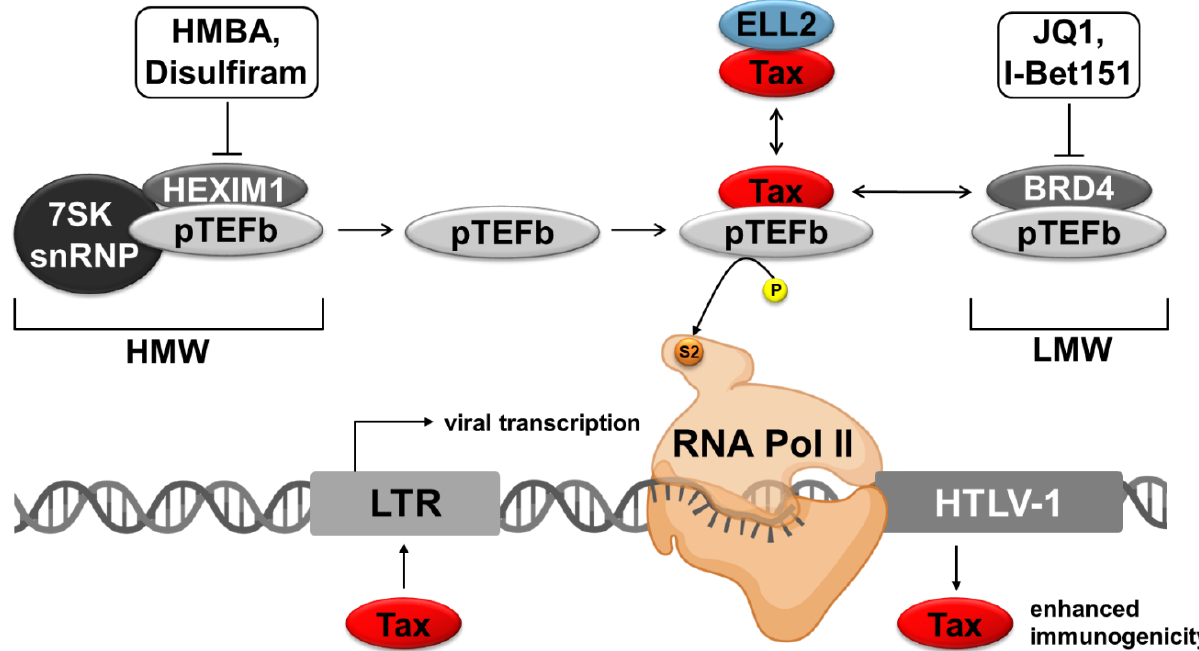
Figure 3. Activators of pTEFb as latency-reversing agents for HTLV-1. The cellular function of the positive transcription elongation factor b (P-TEFb) is to release the RNA Pol II from promoter proximal pausing by phosphorylating Ser2 in the carboxyterminal domain. The level of activity of P-TEFb is governed by its existence in complexes with different cellular proteins. In the inactive high molecular weight complex (HMW), P-TEFb interacts with HEXIM1 and 7SK snRNP; in the low molecular weight complex (LMW), P-TEFb complexes with BRD4, thus, activating transcription. Targeting these complexes to achieve the release of P-TEFb facilitates the binding of P-TEFb to the viral transactivator Tax. The complex of pTEFb and Tax could activate HTLV-1 transcription most effectively, resulting in enhanced Tax protein expression. Additionally, complexes between the P-TEFb-related transcription elongation factor ELL2 and Tax exist. Abbreviations: P-TEFb, positive transcription elongation factor b; 7SK snRNP, 7SK small nuclear ribonucleoprotein; HEXIM1, hexamethylene bisacetamide inducible protein 1; HMBA, hexamethylene bisacetamide; BRD4, bromodomain-containing protein 4; LTR, long terminal repeat; HTLV-1, human T-cell leukemia virus type 1.